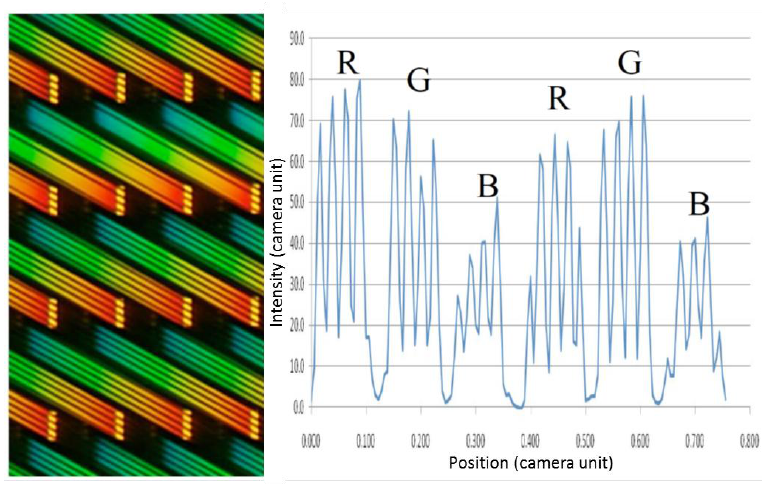
Figure 9. ( Left ) Image of the stripe target made of black and white parallel lines 1.7 pixels wide plus a central white gap. The gap is visible in the second row of slices. ( Right ) Profiles one pixel wide through 6 different spectra showing the contrast in the red at left, then green, blue, red, green &